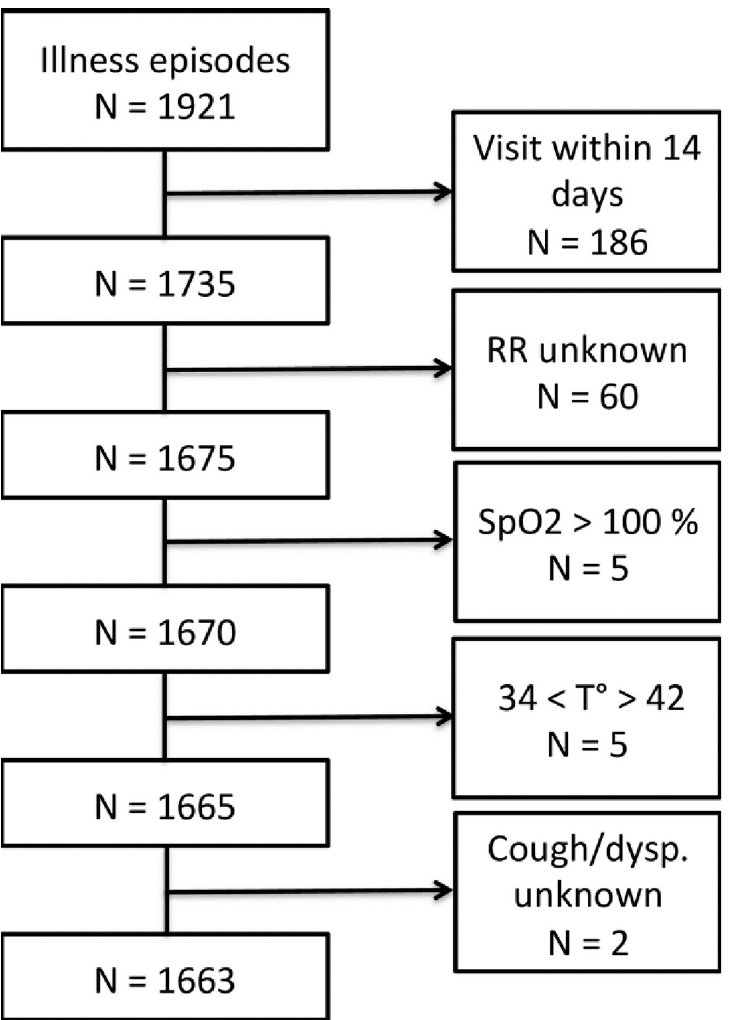
Fig 1. Study flowchart. Abbreviations: RR: Respiratory Rate, SpO 2 : peripheral arterial oxygen saturation measured with pulse oximetry, T˚: Temperature.